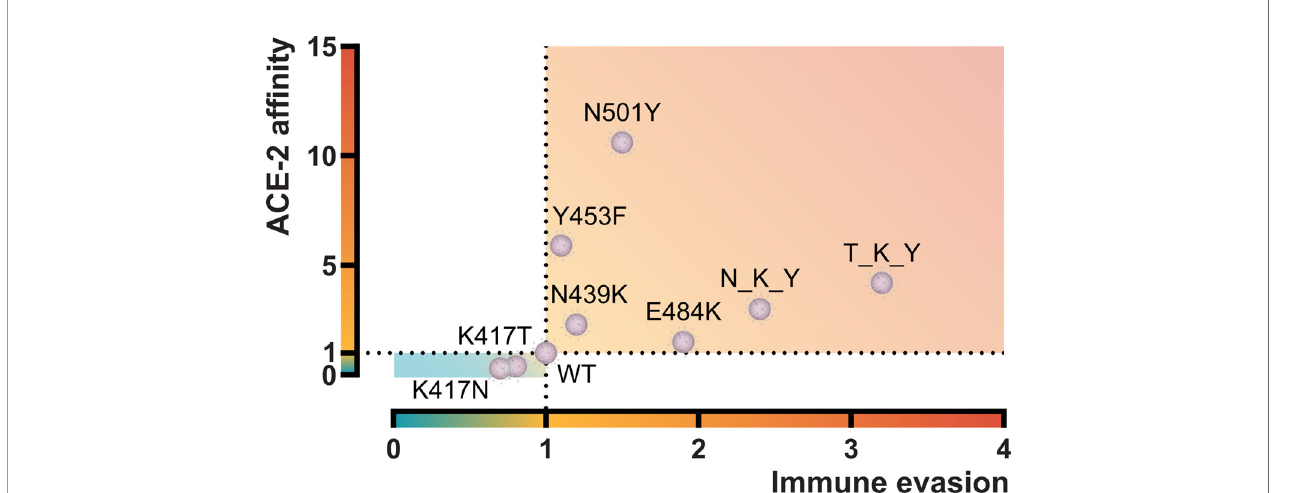
FIGURE 6 | Graphical representation of the ACE-2 af fi nity and immune evasive capacity of RBD variants. ACE-2 af fi nity was calculated by BLI and represented as fold difference compared to the RBD wt. Immune evasion was calculated using an ELISA-based ACE-2/RBD antibody inhibition assay (18) and represented as the fold- difference of the median antibody-mediated inhibition of convalescent sera. N_K_Y, B.1.351 RBD (K417N + E484K + N501Y); T_K_Y, P.1 RBD (K417T + E484K + N501Y). Sources (12, 18) and unpublished